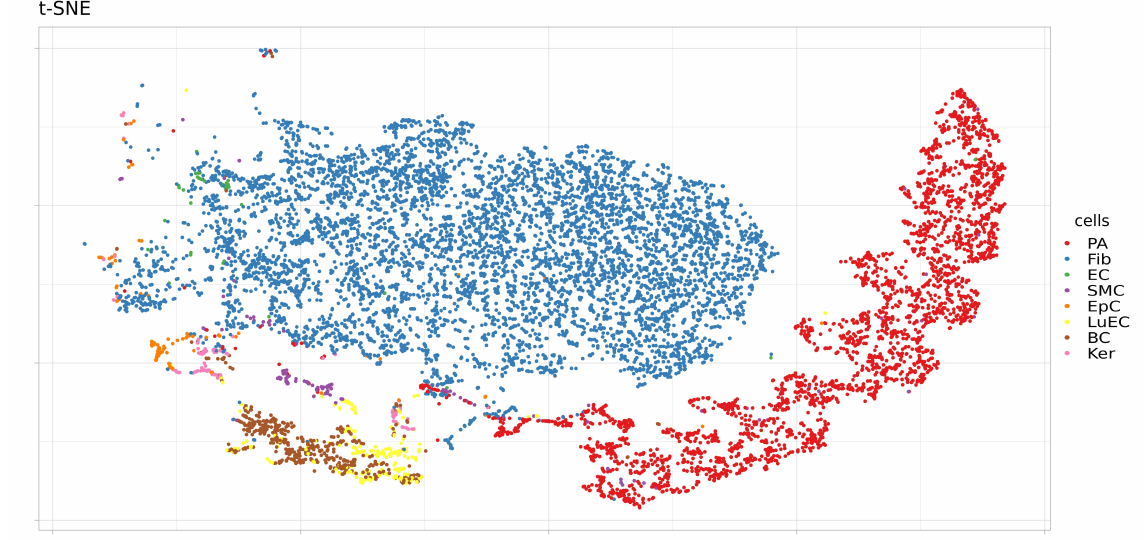
Figure 6. Cell types in a single sample (SRS2769051) of proximal stromal lung cells. PA, pulmonary alveolar type II cells; Fib, fibroblasts; EC, endothelial cells; SMC, smooth muscle cells; LuEC, luminal epithelial cells; BC, basal cells; Ker, keratinocytes. Color intensity indicates the level of expression in a single